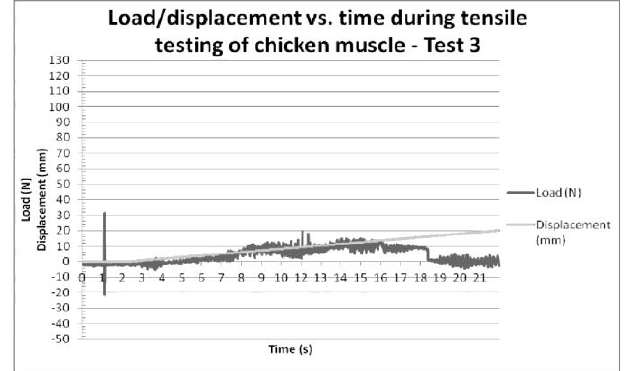
Figure 7. Load /displacement against time during test 3 on chicken tissue in which specimen